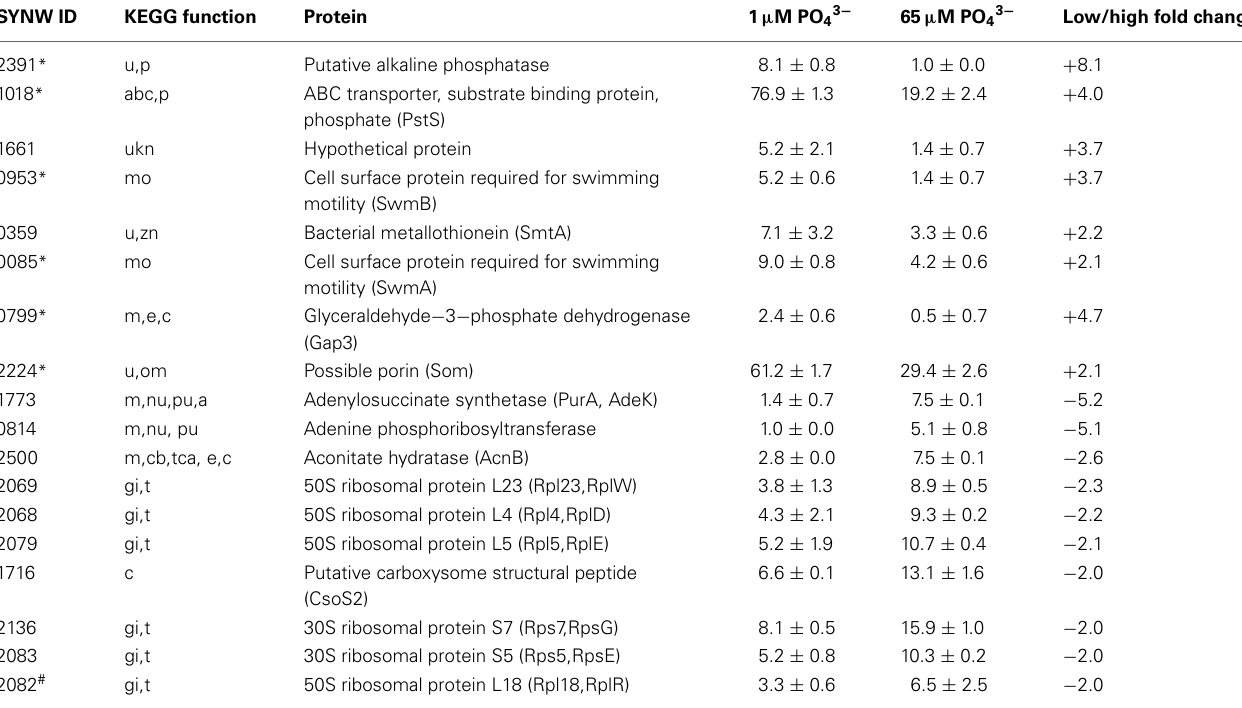
Table 1 | Relative protein abundances between low and high phosphate treatments for proteins two-fold or greater differentially abundant (1 µ M PO 43 − and 65 µ M PO 43 − , replete Zn for